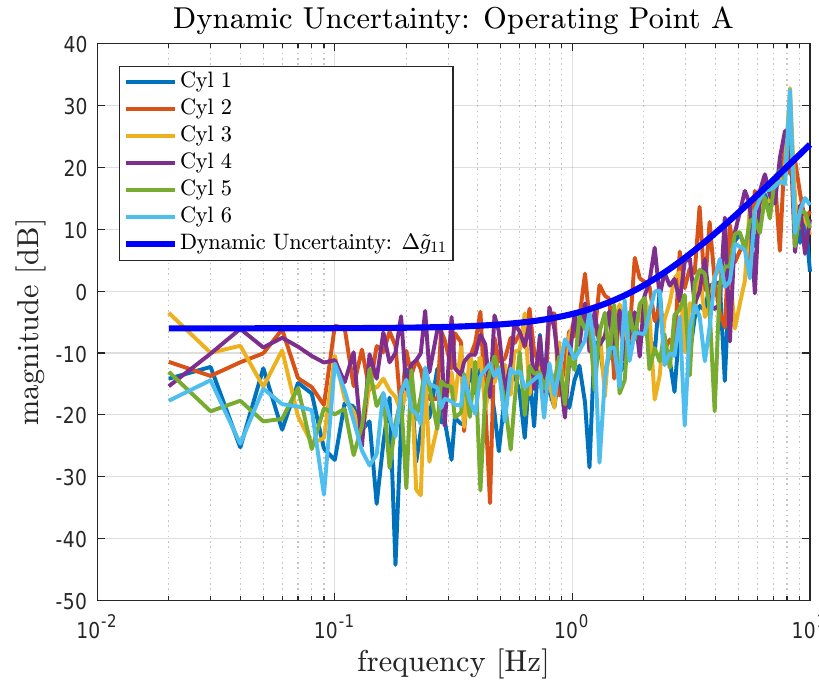
Figure 6. Dynamic combustion uncertainty model ∆ ˜ g 11 .